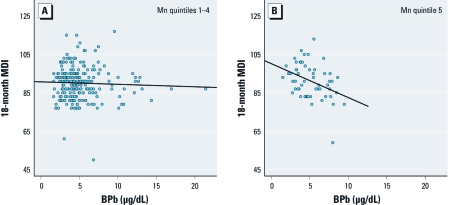
Scatterplots and regression lines of 12-month blood lead (BPb) and 18-month MDI among children with 12-month blood manganese (Mn) in quintiles 1–4 (A) and quintile 5 (B).